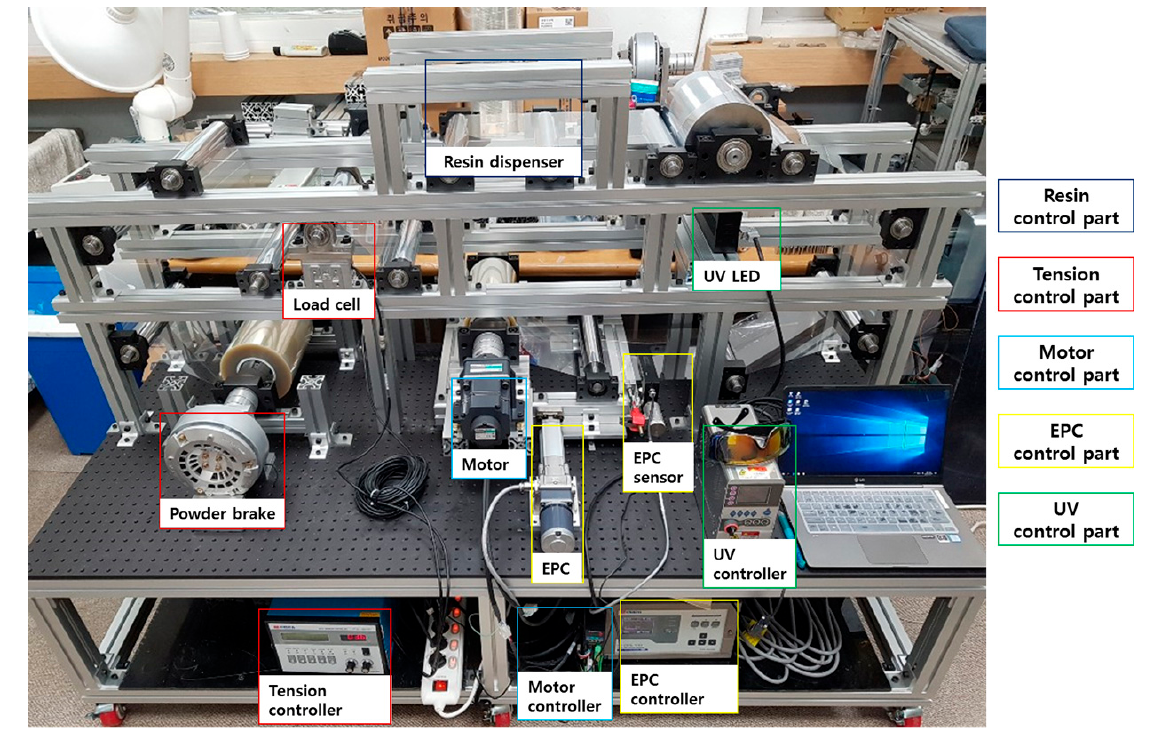
Figure 4. Optical image of the automatic R2R imprint equipment.